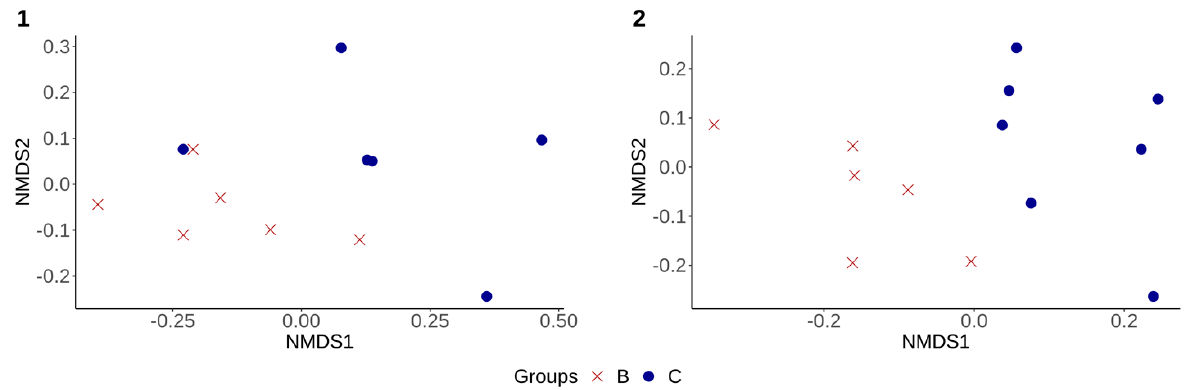
Figure 4. Non-metric multidimensional scaling (NMDS), using Bray–Curtis distance matrix. ( 1 ) Showed significant differ- ence ( p < 0.05, R 2 = 0.13) in the fecal microbiota structure between groups B and C at Day 7. ( 2 ) Showed significant difference ( p < 0.05, R 2 = 0.16) in the fecal microbiota structure between groups B and C at Day 36. B —challenged treated group. C — unchallenged treated group.